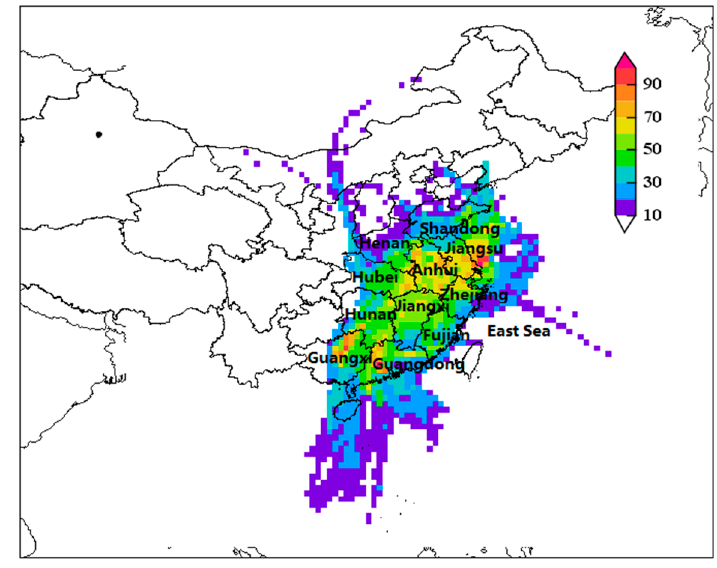
Figure 11. PM 2.5 concentration weight trajectory distribution.